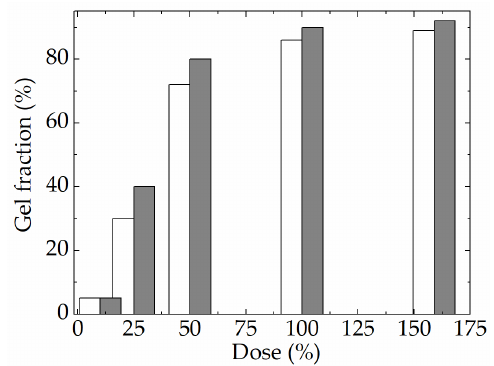
Figure 9. The percentage of gel fraction formed in irradiated EPDM [47]. ( white ) pristine polymer, ( light grey ) polymer with PbZrO 3 /Nb doped nanoparticles. (light grey) polymer with PbZrO 3 /Nb doped